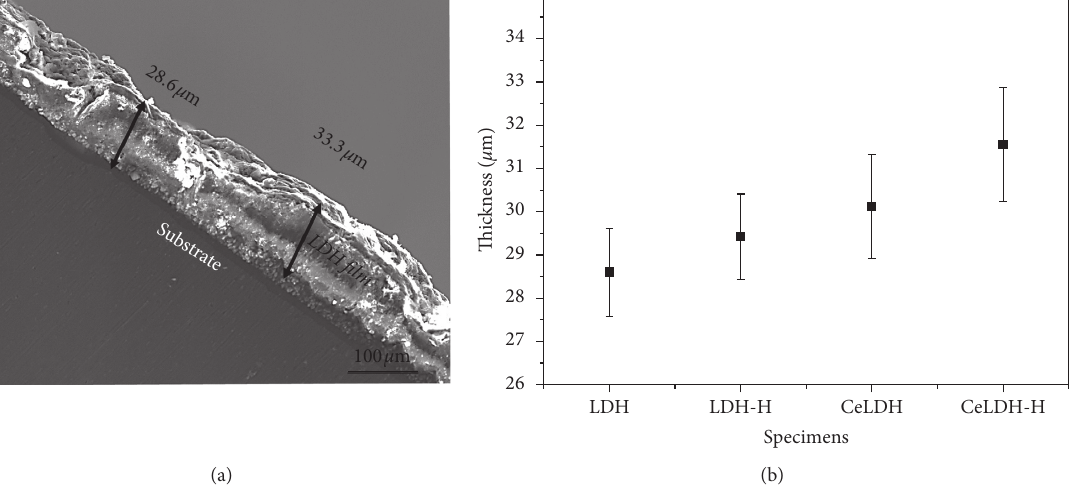
Figure 5: (a) Cross-sectional analysis of CeLDH and (b) film thickness of developed